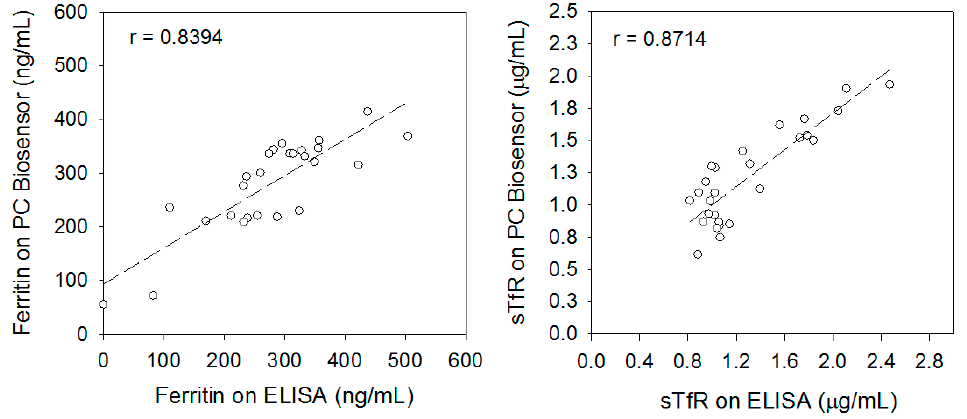
Figure 3. Comparison plots showing the analytical range and Pearson correlation coefficient of ferritin and sTfR measured in sera of hemodialysis patients using the PC biosensor and ELISAs. There were differences in random error (F-test, Equation 5) between bioassays when